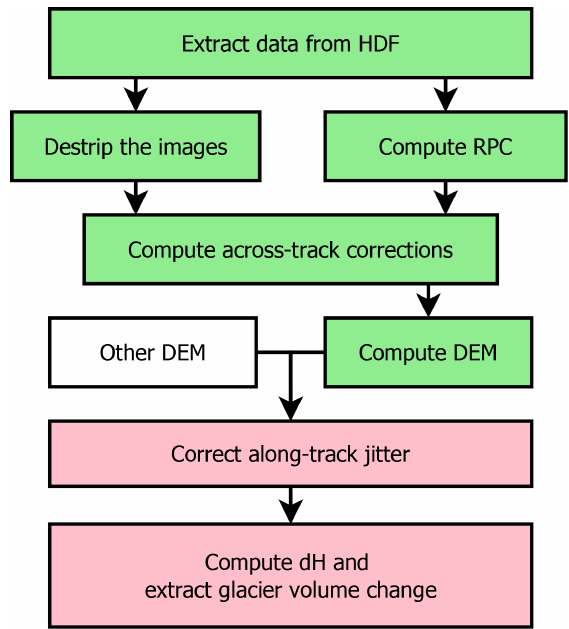
Figure 2: Diagram of the overall method. Green, as presented in (Girod et al., 2015) and recapped in section 2.1. Red, presented in this paper in section